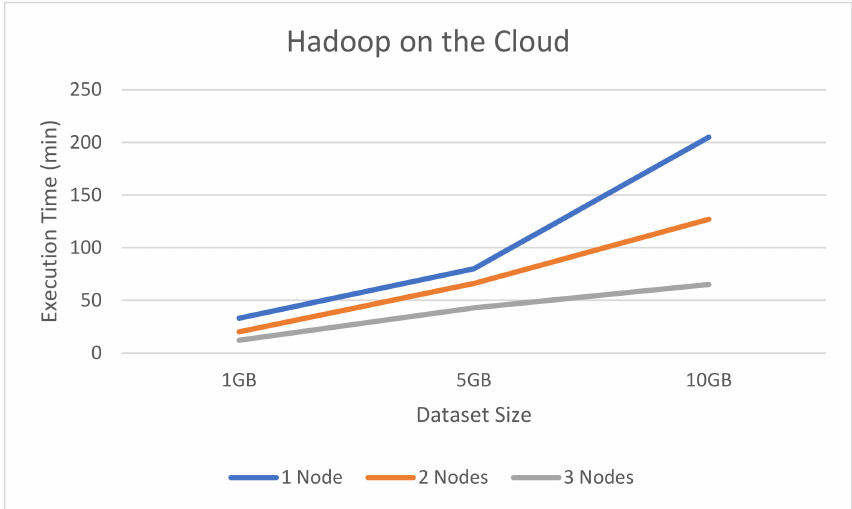
Figure 10. Execution time of Hadoop on the